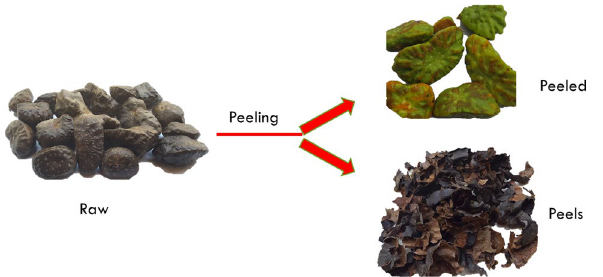
Figure 1. Raw wild D. bulbifera carefully separated into peels and peeled